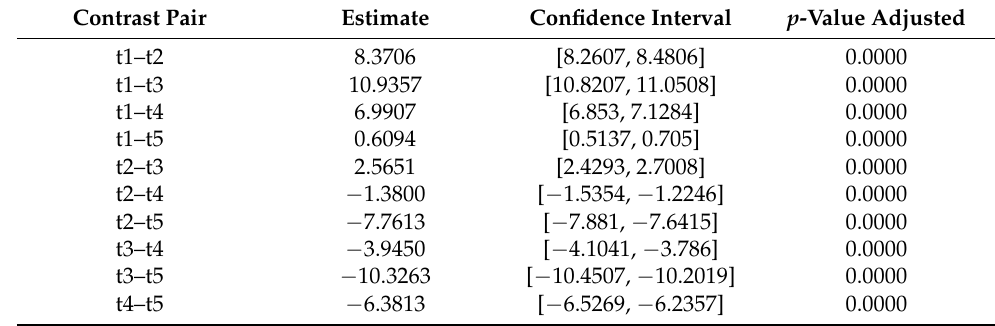
Table A2. Pairwise comparison in energy at different sun levels using Games-Howell